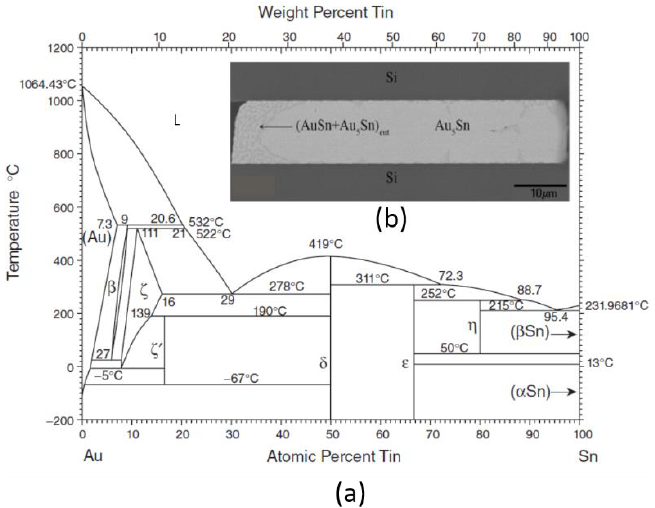
Figure 13. ( a ) Au-Sn phase diagram. Six different intermetallic compound (IMC) layers can form during Au-Sn solid-liquid interdiffusion (SLID) bonding; ( b ) Scanning electron microscope (SEM) image of Au-Sn SLID seal [123]. Reprinted with permission from the Minerals, Metals, and Materials Society.